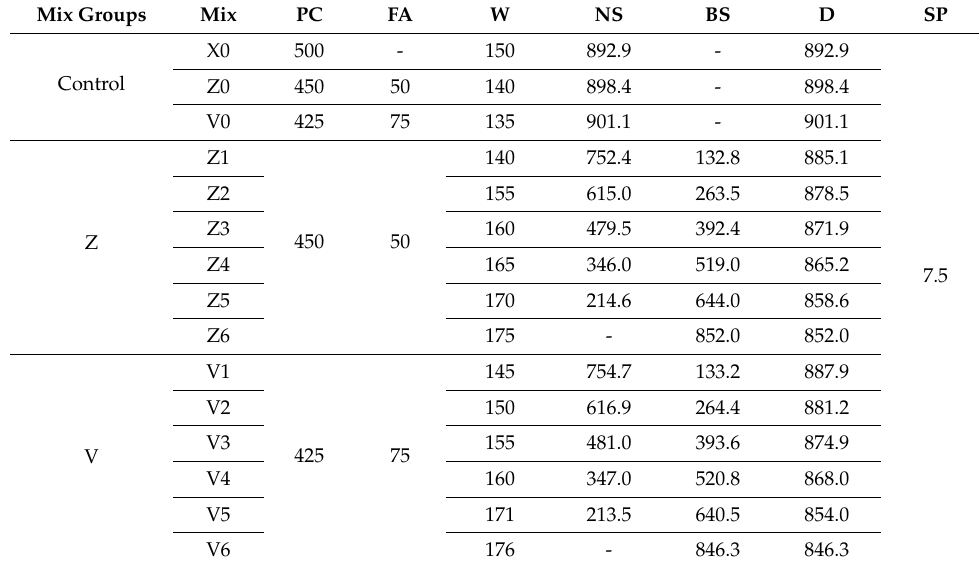
Table 2. Mixes proportion (kg/m 3